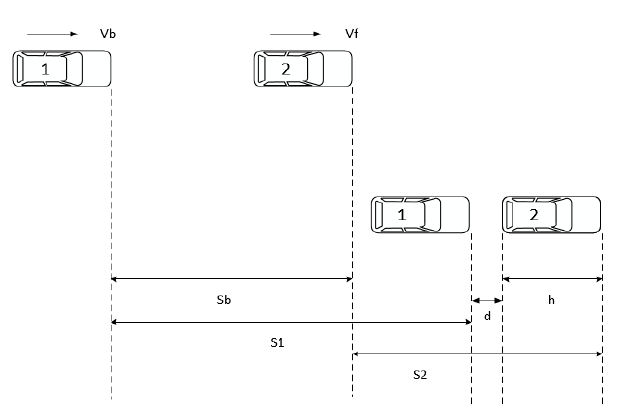
Figure 6. The one-way front and rear following vehicle scene.